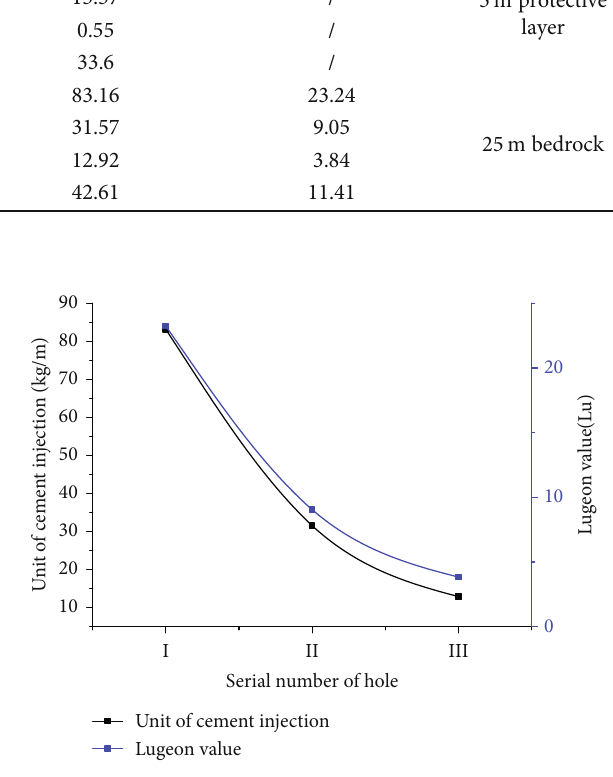
Figure 9: Trend chart of units of cement injection and Lugeon